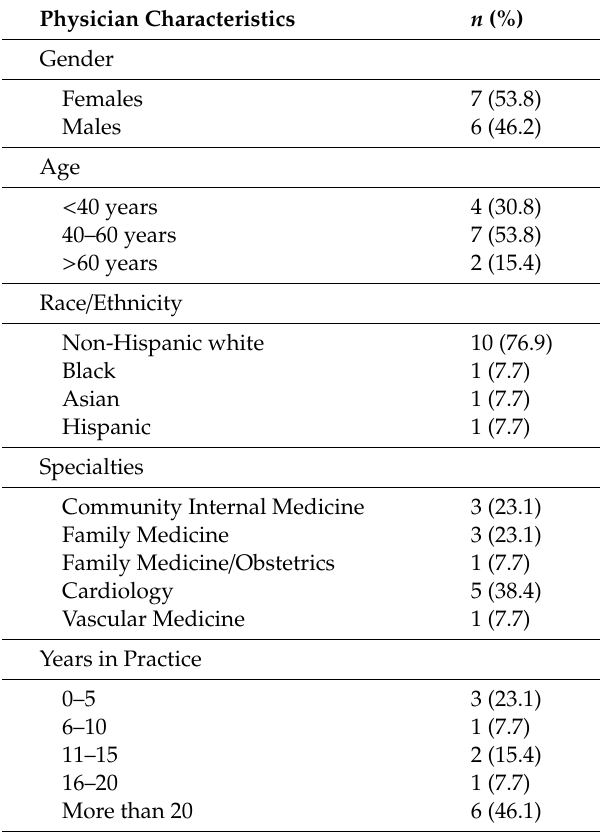
Table 1. Physician characteristics ( n = 13).